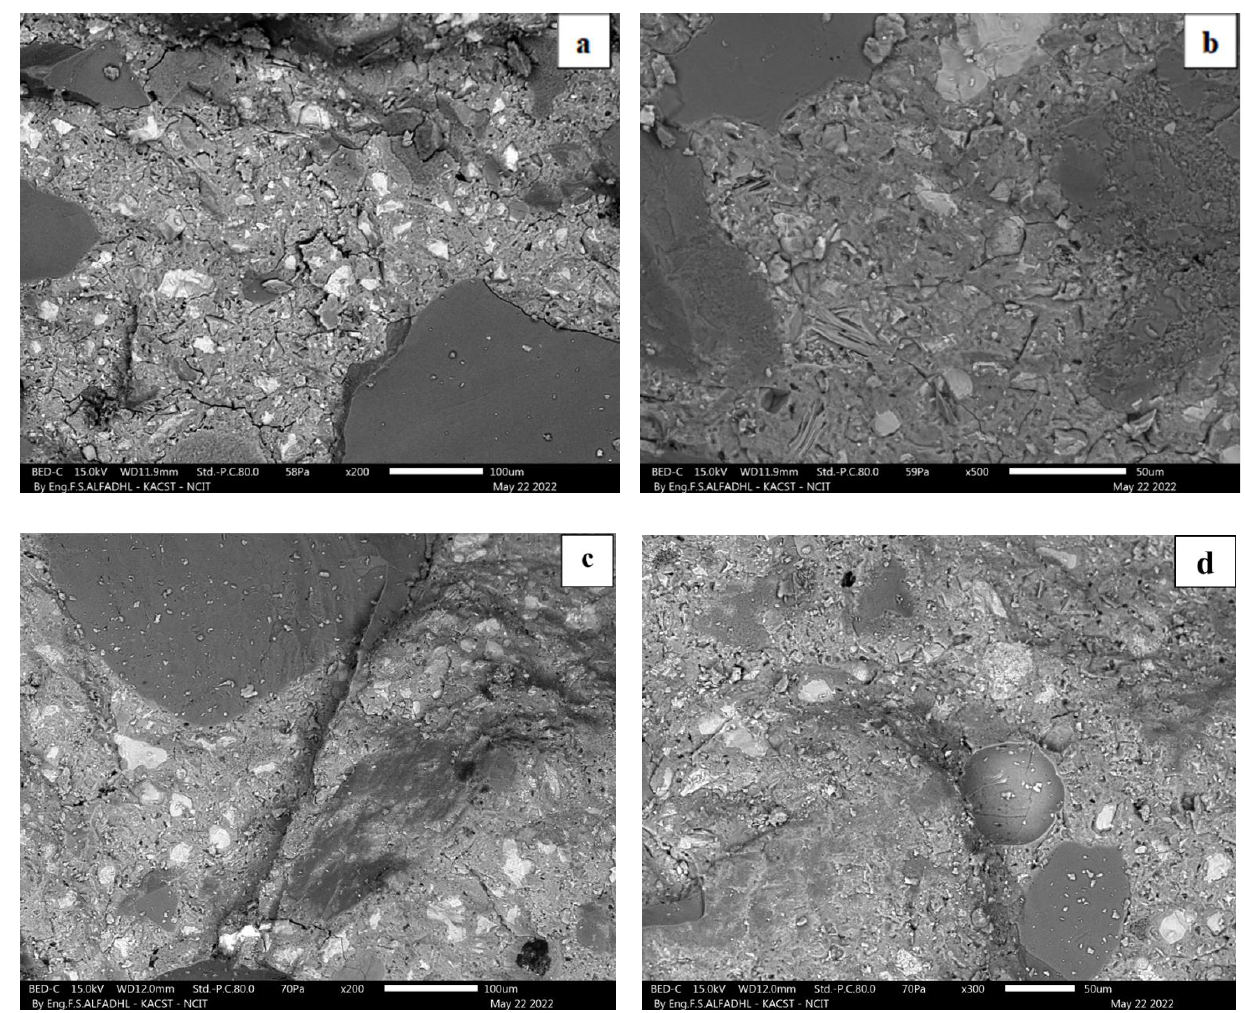
Figure 7. Microstructural SEM images of UHPC-L0: ( a ) ambient at 200× magnification; ( b ) ambient at 500× magnification; ( c ) 200 °C at 200× magnification; and ( d ) 300 °C at 300× magnification.